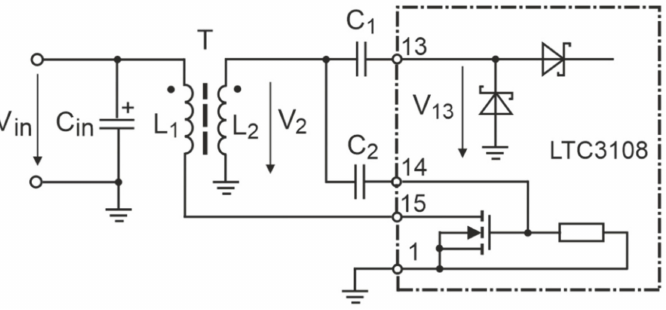
Figure 8. Simplified scheme of the first stage of the DC/DC step-up